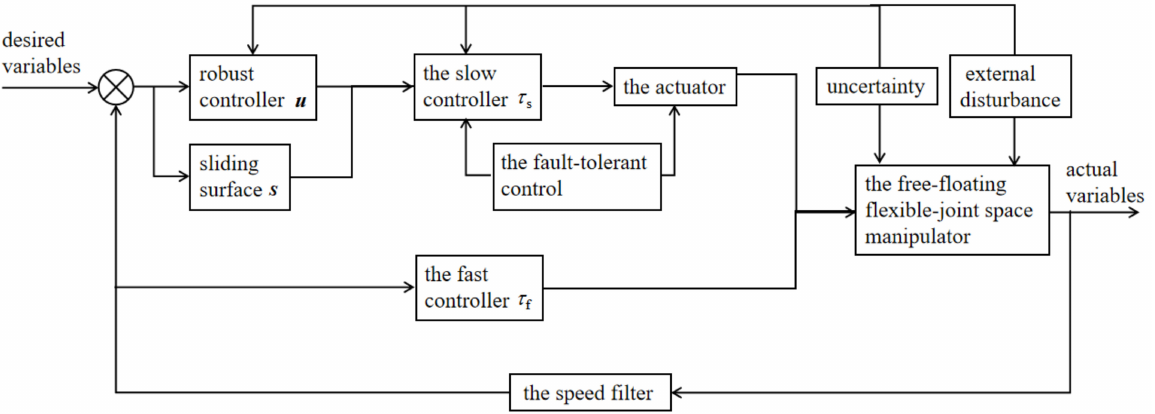
Figure 3. The control